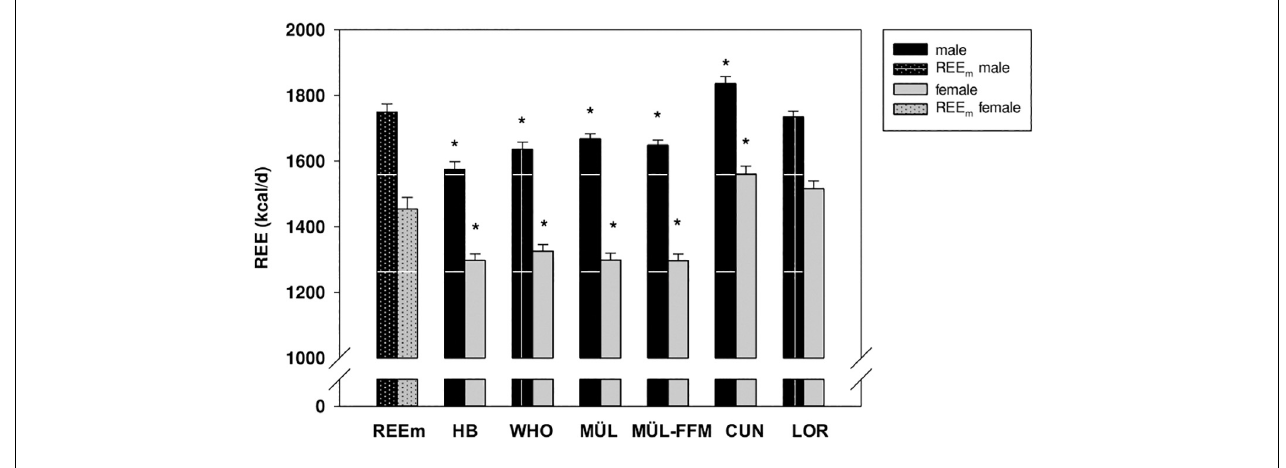
FIGURE 2 | Directly-measured resting energy expenditure (REE) (REEm) and predicted REE (REEp) using a variety of equations including Harris & Benedict (H&B), World Health Organization (WHO), Müller (MÜL), Müller-FFM (MÜL-FFM), Cunningham (CUN), and De Lorenzo (LOR) in males and female master athletes. * p < 0.005 vs.